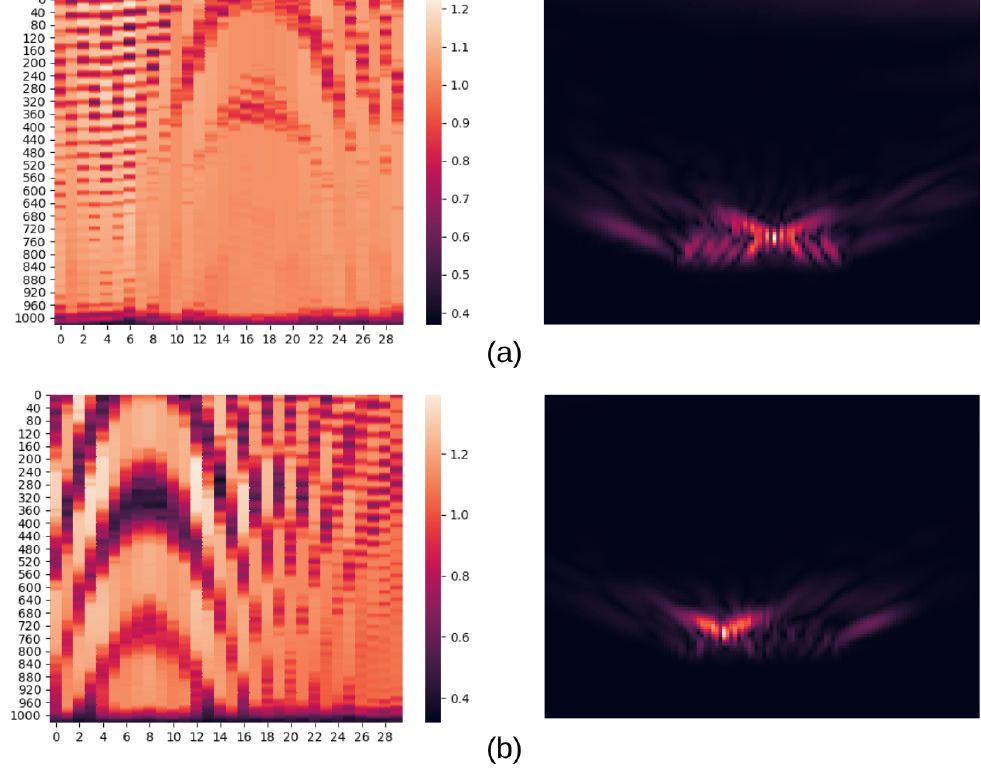
Figure 14. RealSAR-RAW (left) and RealSAR-IMG (right) misclassified examples. Example ( a ) is misclassified by the IMG model while example ( b ) is misclassified by both RAW and IMG models. In ( a ) the recorded scene included a glass bottle, but IMG model classified it as plastic bottle. In ( b ) the recorded scene included an aluminium and a plastic bottle but both models classified it as scene with an aluminium bottle